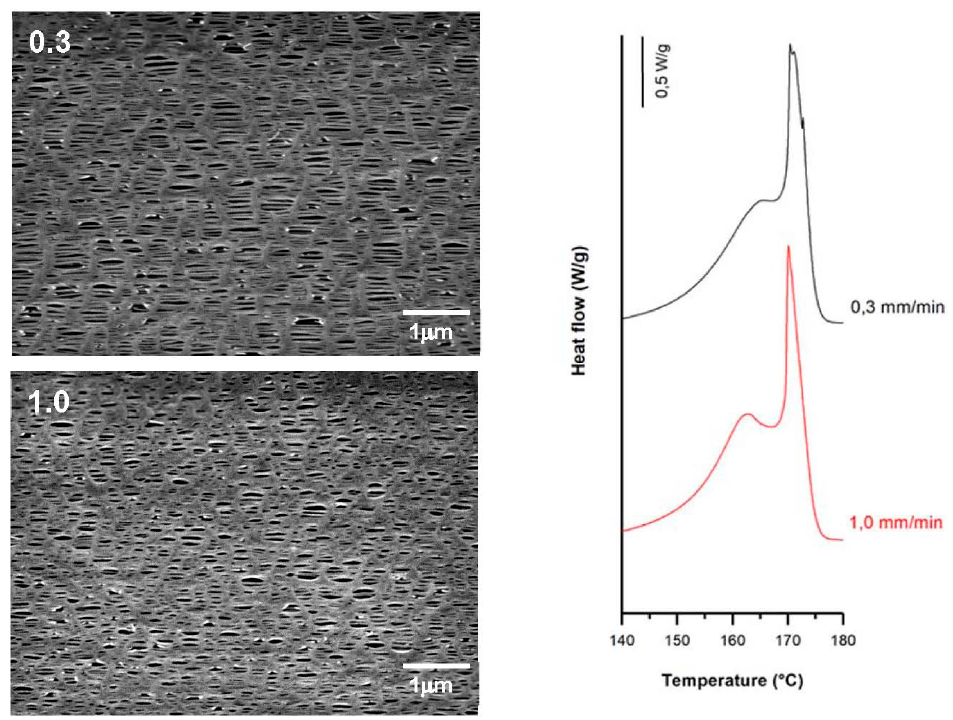
Figure 8. Influence of same cold and hot strain rates (upper-left, in mm/min). Common uniaxial strain conditions. Cold stage= 35%; hot stage = 320%.